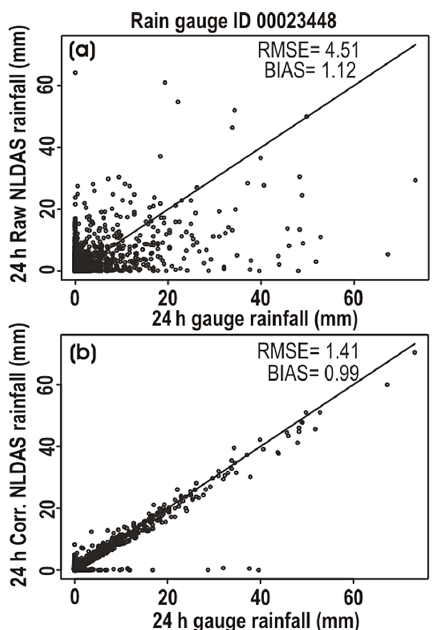
Figure A2. Scatter plot of daily rainfall depths between (a) the raw NLDAS product and gauge rainfall and (b) the bias corrected NL- DAS product and the gauge rainfall for an example rainfall station (ID 00023448) and collocated NLDAS